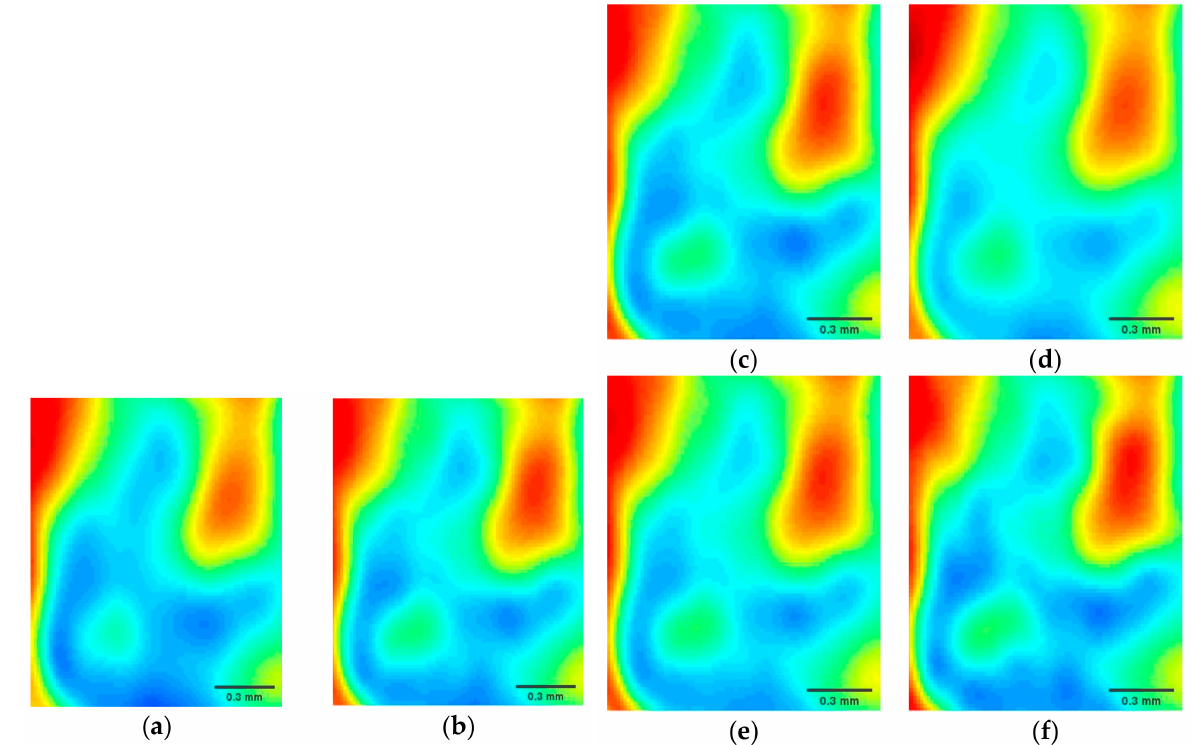
Figure 8. Reconstructed results comparation of DSC-THz and SSC-THz with different sampling rates at the selected regions. ( a ) DSC-THz with sampling rate 20%; ( b ) DSC-THz with sampling rate 30%; ( c ) DSC-THz with sampling rate 40%; ( d ) SSC-THz with sampling rate 20%; ( e ) SSC-THz with sampling rate 30%; ( f ) SSC-THz with sampling rate 40%.